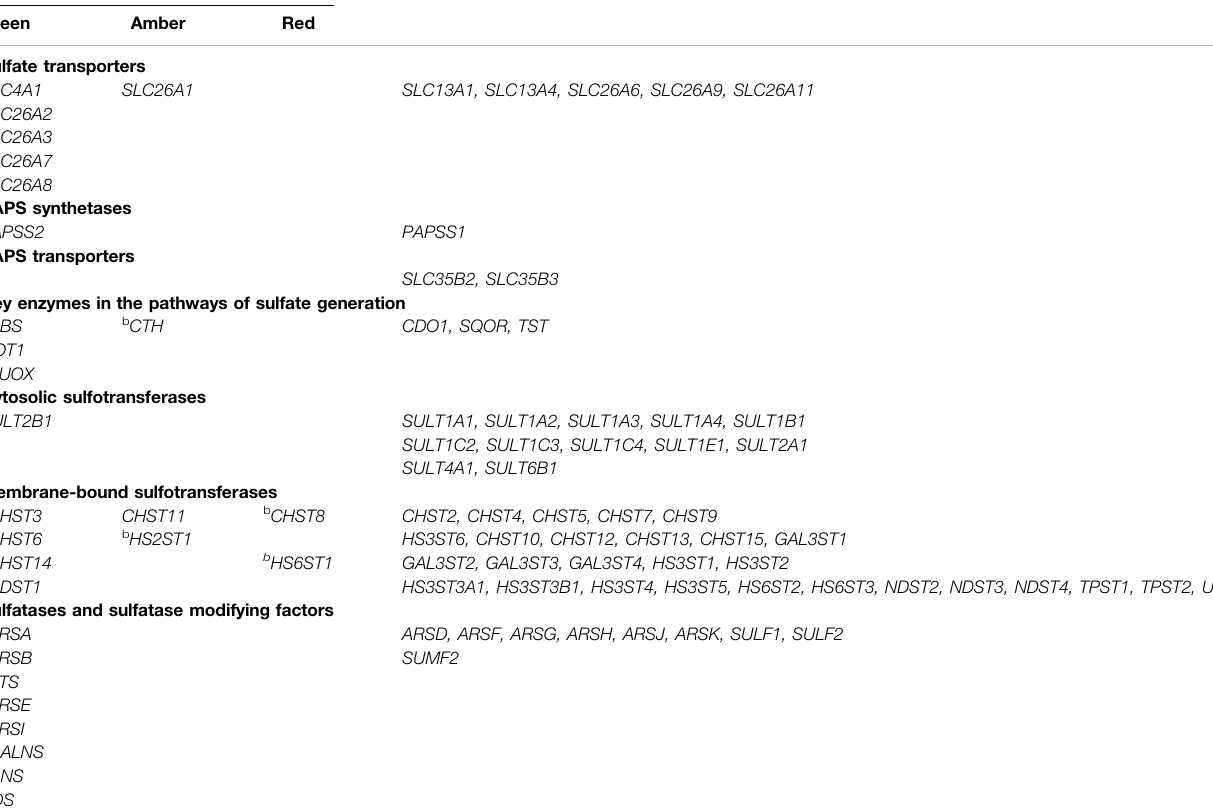
TABLE 1 | Sulfate biology genes that are either clinically reportable or not yet captured in clinical genetics. a Clinically reportable genes Genes that have been investigated in research settings but are not yet captured in clinical resources